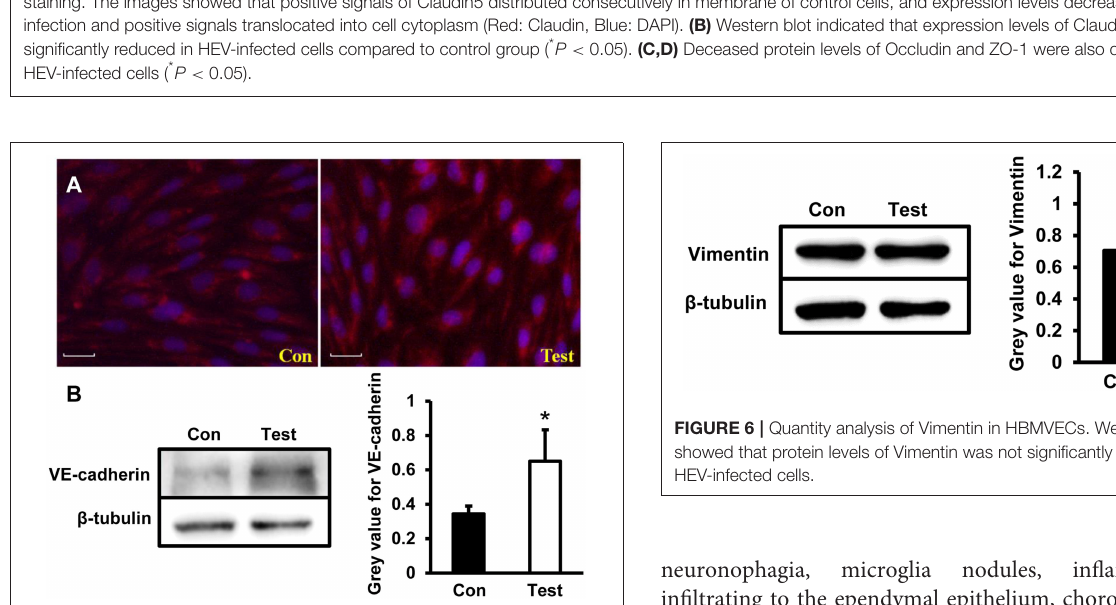
FIGURE 5 | Quantity analysis of adherent junction protein (VE-cadherin) in HBMVECs. (A) Representative images of Immunofluorescence staining. The images showed that VE-cadherin expressed as scattering points around cell membrane between two adjacent cells in control cells, and positive signals increased in HEV-infected cells (Red: VE-cadherin, Blue: DAPI). (B) Western blot analysis showed that VE-cadherin expression levels were increased in HEV-infected HBMVECs ( * P < 0.05).